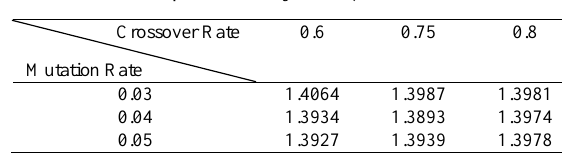
Table 4. Unit production cost under various values